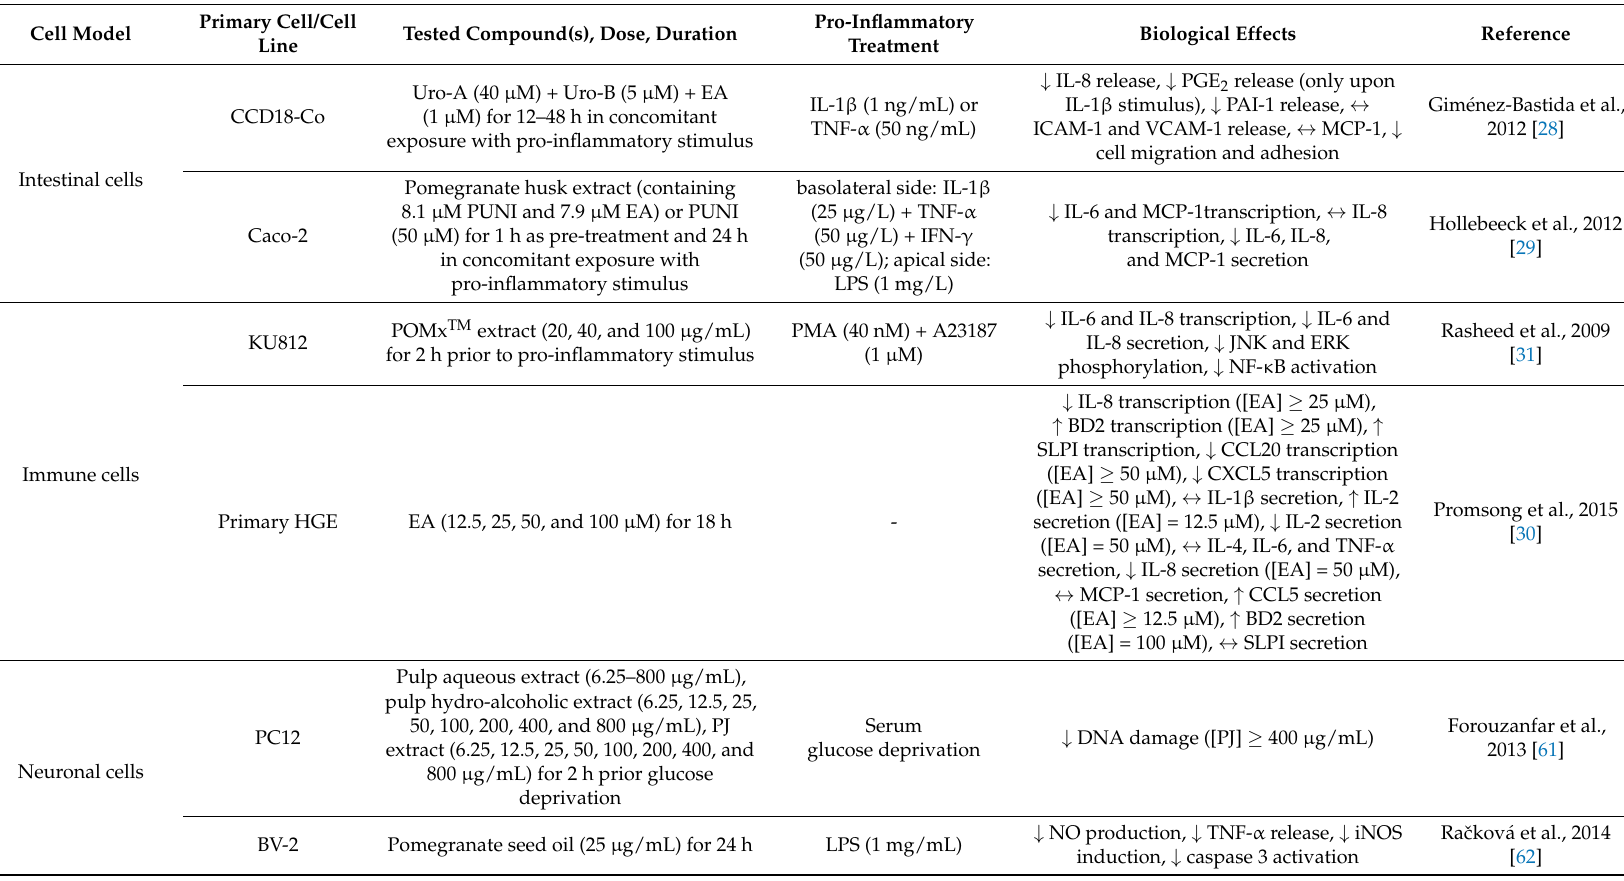
Table 5. Summary of the anti-inflammatory effects of pomegranate extracts or pomegranate-derived bioactive compounds assayed in cell culture